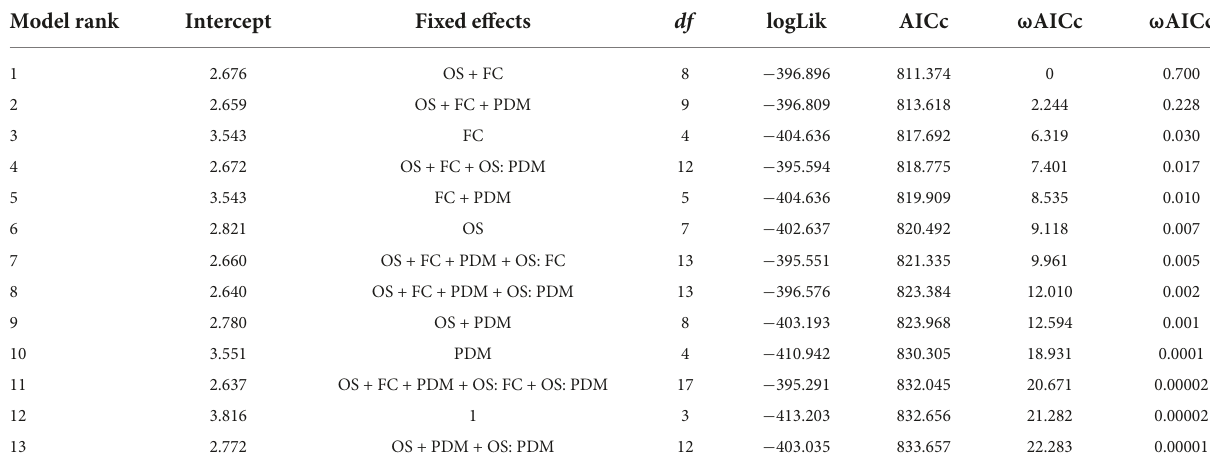
TABLE 1 Top-ranked candidate models, and their respective Akaike’s information criterion with small sample size correction (AICc), the difference between a given model and the best model ( (cid:49) AICc), and the Akaike weights ( ω AICc). Model rank Intercept Fixed